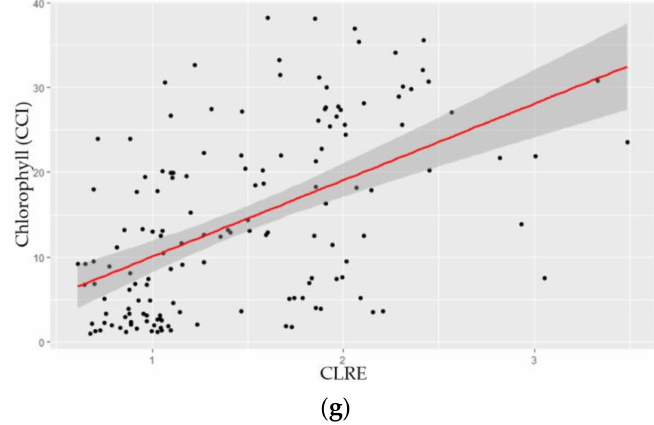
Figure 1. Sustainability trait models for chlorophyll content. Statistical models developed from UAV-based multispectral camera data and verified with ground-based data. ( a ) normalized difference red edge (NDRE); ( b ) normalized difference vegetation index (NDVI); ( c ) chlorophyll vegetation index (CVI); ( d ) green leaf index (GLI); ( e ) ratio vegetation index (RVI); ( f ) chlorophyll index green (CLG); ( g ) chlorophyll index red edge (CLRE). X -axis represents the vegetation index, and y -axis represents the chlorophyll content index (CCI) measured from the chlorophyll content meter, defined as CCI = % transmittance at 931 nm/% transmittance at 653 nm.